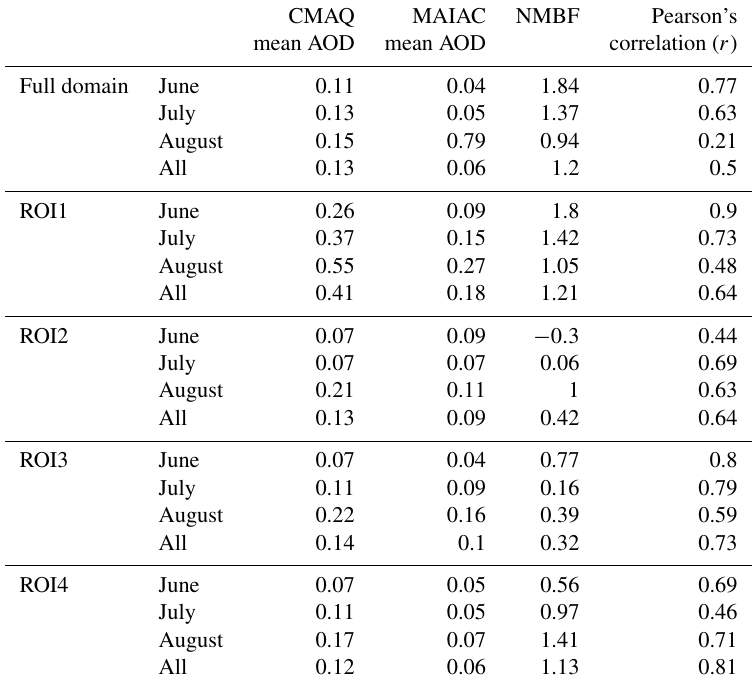
Table D2. Monthly means of daily CMAQ and MAIAC AOD, in the full extent of the domain and the ROIs, the NMBF of daily CMAQ AOD with respect to observations, and the temporal Pearson correlation coefficient of daily AOD over each month and the whole modelled period are also included (15 June to 29 August